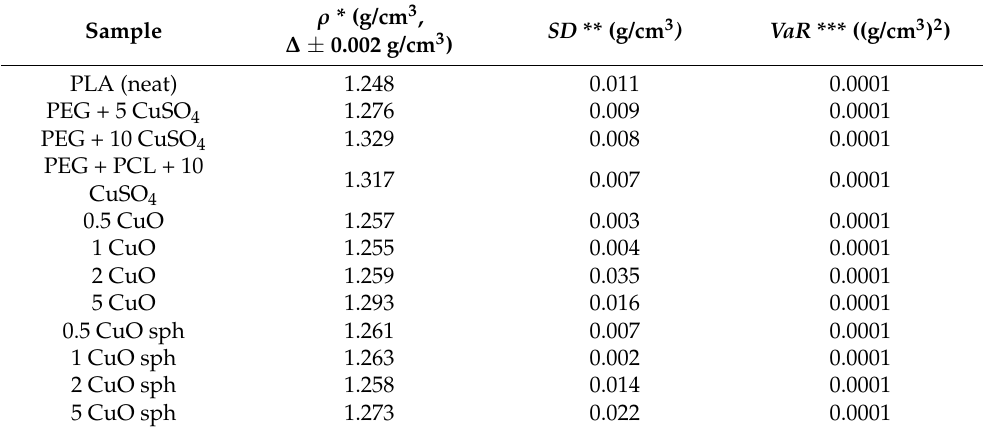
Table 4. Density of the PLA and PLA-based composites (hydrostatic weighing).